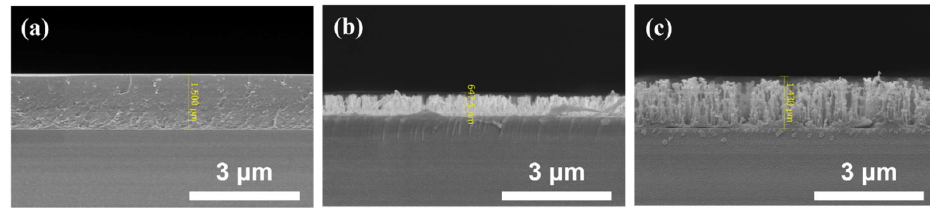
Figure 8. Cross-sectional scanning electron microscopy images of diffusion layer: ( a ) Unpatterned SU-8, ( b ) RNSs 1-3, and ( c ) RNSs